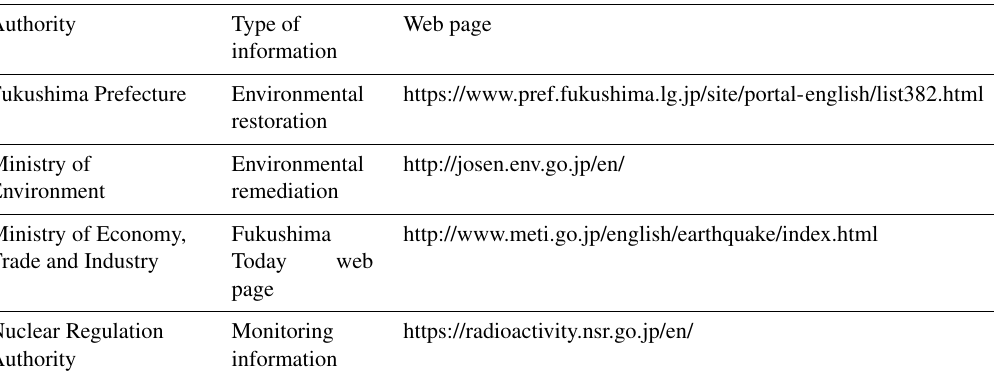
Table 1. Selection of official websites from the Japanese authorities providing information on the remediation works and their impact. (Last access to these websites was on 21 November